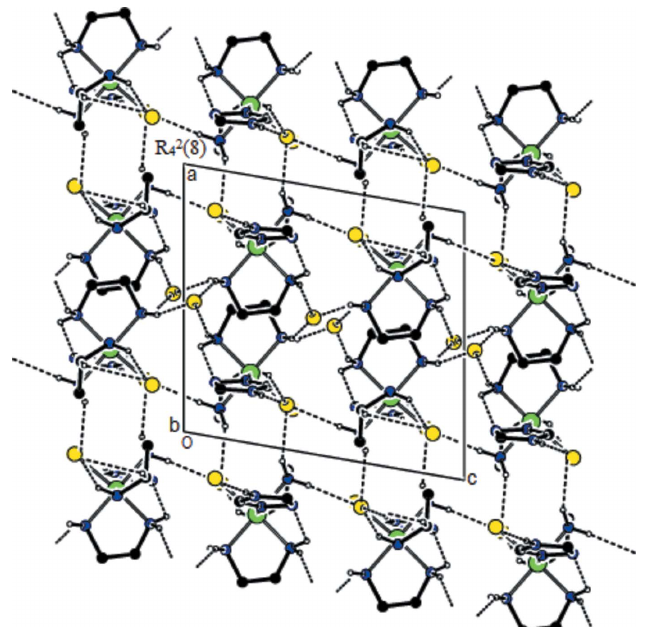
Figure 2 A view along the b axis of the crystal packing of the title complex. The